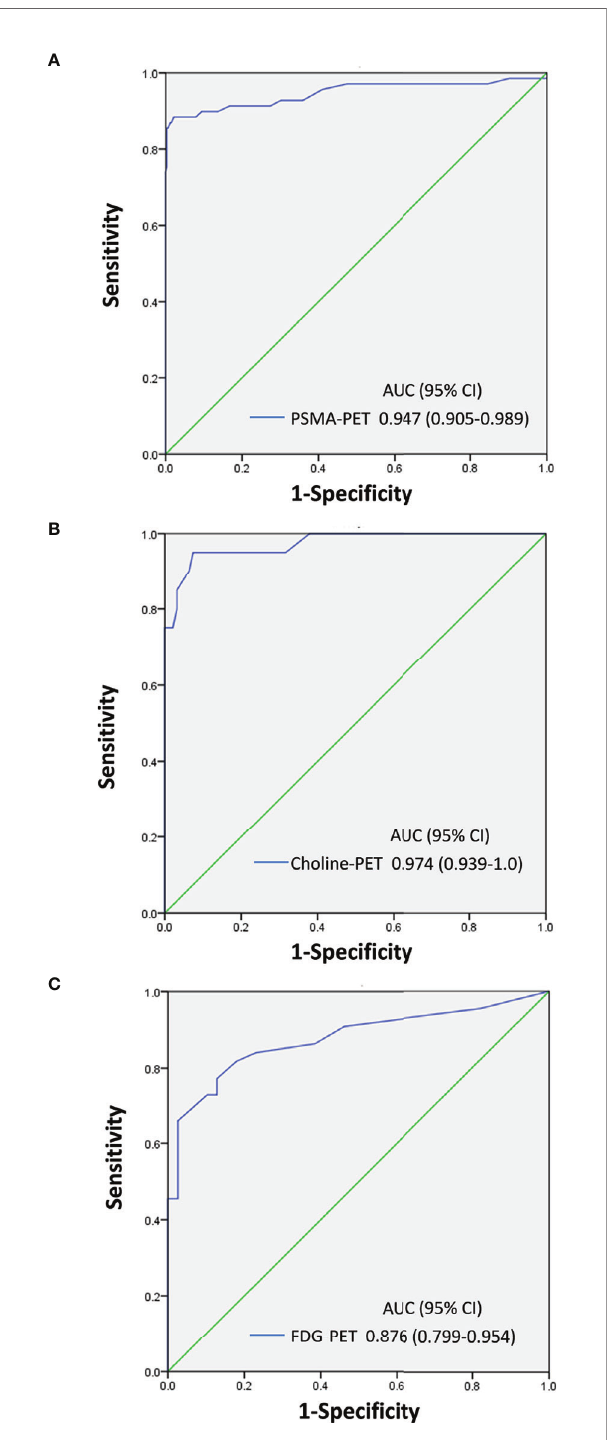
FIGURE 5 | SUVmax of PSMA-PET, choline-PET and FDG-PET for distinguishing between LNM and ganglia. (A) PSMA-PET receiver-operating characteristic (ROC) curve analysis showing sensitivity, speci fi city, and area under curve. (B) Choline-PET receiver-operating characteristic (ROC) curve analysis showing sensitivity, speci fi city, and area under curve. (C) FDG-PET receiver-operating characteristic (ROC) curve analysis showing sensitivity, speci fi city, and area under